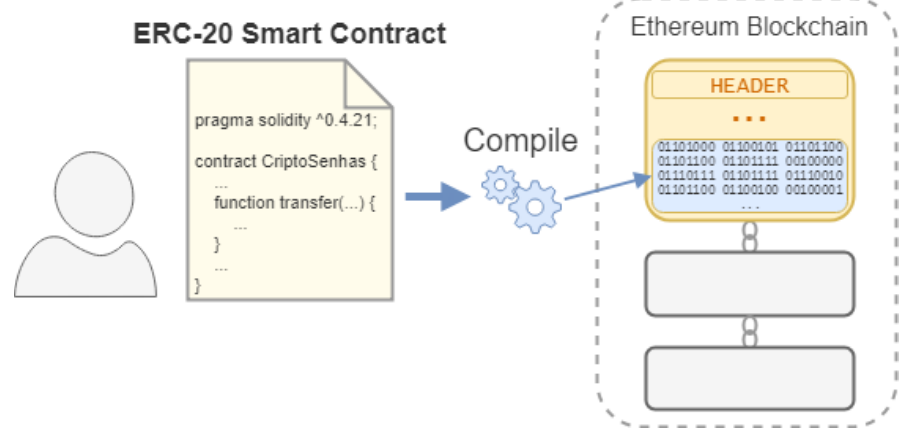
Figure 13. Smart Contract compilation and bytecode registration at Blockchain.